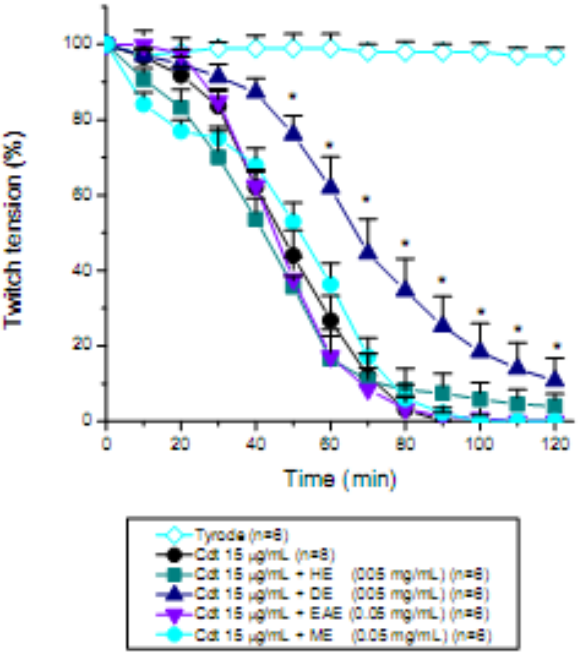
Figure 4. Pharmacological assays on mouse phrenic nerve-diaphragm preparations to determine the twitch response under electric indirect stimuli after incubation the preparation with 15 µg/mL Crotalus durissus terrificus (Cdt) venom pre-incubated for 30 min with the D. alata barks extract (0.05 mg/mL) using different solvents (HE, hexane; DE, dichloromethane; EAE, ethyl acetate; ME, methanol). Note that none of the extracts were able to prevent the total neuromuscular blockade promoted by Cdt venom, except DE which did not prevent the blockade but instead delayed temporarily its appearance. Each point represents the mean ± S.E.M. of the number of experiments (n) showed in the legend. *p < 0.05 compared to